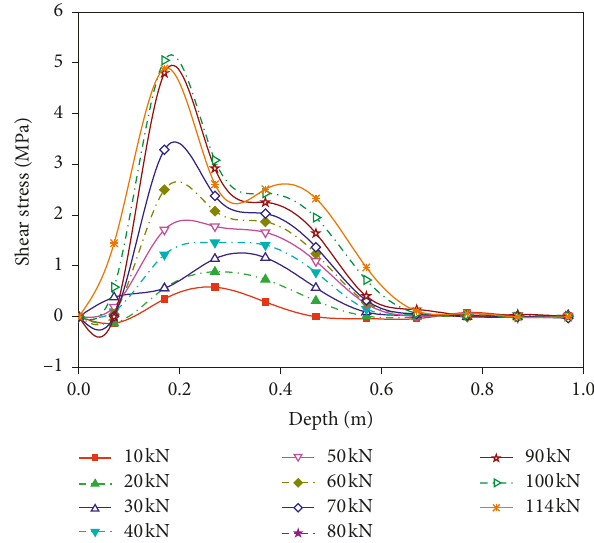
Figure 11: Single load shear stress curves obtained along the length of samples under unconstrained conditions.